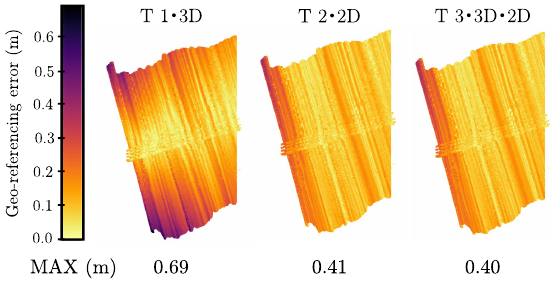
Figure 6. Western part of the point-cloud of flight line